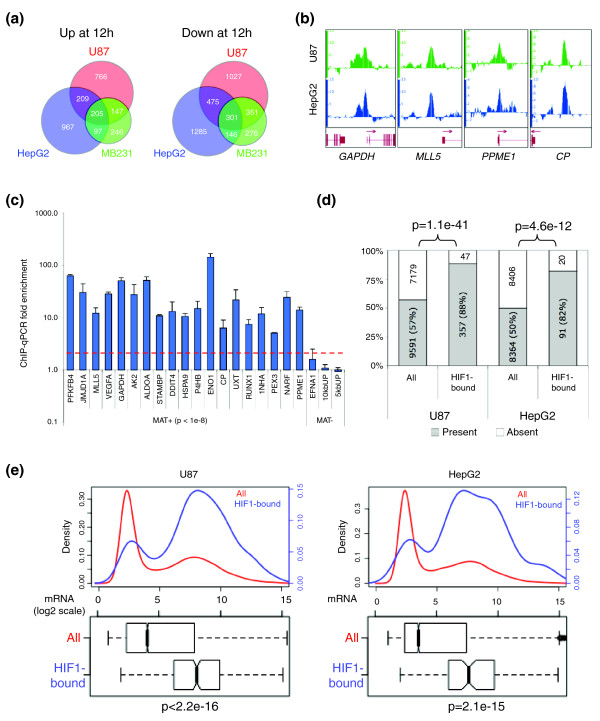
HIF-1 preferentially binds to promoters of transcriptionally active genes. (a) Proportional Venn diagrams of genes with mRNA expression significantly (P-value < 0.01) up- or down-regulated after 12 h of hypoxia in U87, HepG2, and MDA-MB231 cells. (b) Results of HIF-1 ChIP-chip analysis on promoter arrays (U87) was highly similar to analysis on whole genome arrays (HepG2). Representative Integrated Genome Browser tracks are shown with the same scale for both cell types. (c) ChIP-quantitative PCR validation of U87 HIF-1 ChIP hits. Data expressed as fold enrichment relative to input (mean ± standard deviation of independent replicates). An increase of more than two-fold (red dashed line) was considered positive for HIF-1 binding. 10 kbUP and 5 kbUP are negative control regions. (d) Approximately half of all genes in the genome are expressed (Present MAS5 call) and half are not expressed (Absent MAS5 call) under normal growth conditions (All) in both cell lines. Upon stabilization by hypoxia, HIF-1 preferentially binds (HIF1-bound) to the promoter of genes that are present under normal growth conditions. Statistical significance determined by Fisher exact test. (e) Genes bound by HIF-1 in U87 or HepG2 cells (HIF1-bound) have higher levels of basal mRNA expression than the normal distribution of all genes (All). Top panel: density plots of genes at indicated mRNA levels. Bottom panel: box plot of all genes (All) compared to genes bound by HIF-1 (HIF1-bound). Statistical significance determined by Student's t-test. For box plots, the median is indicated by a dark bar, the box bounds the lower and upper quartiles, the whiskers define the data range, and the notches represent the 95% confidence interval.